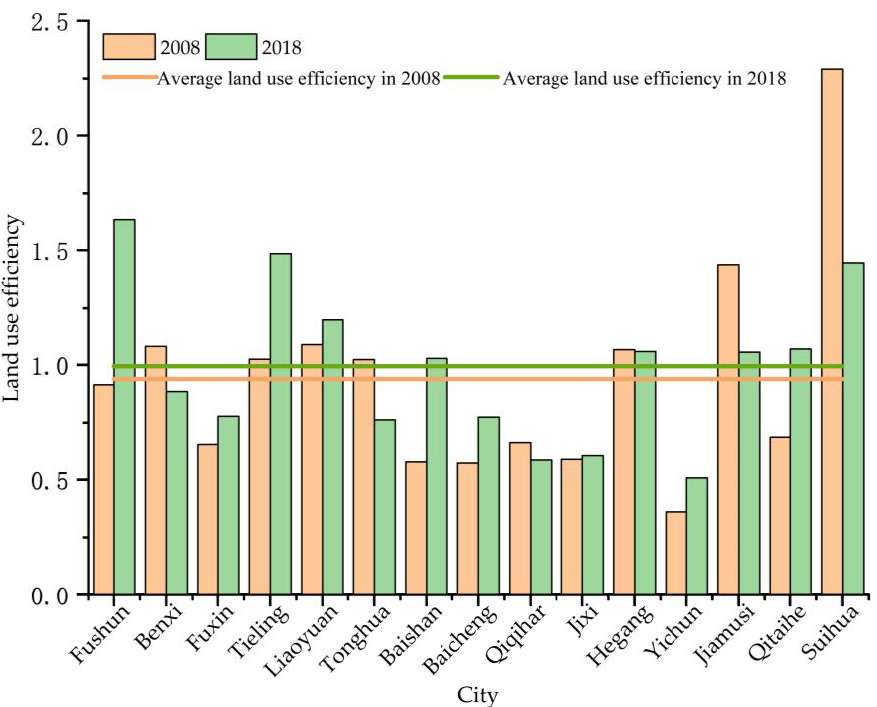
Figure 5. The land-use efficiency of shrinking cities from 2008 to 2018. The yellow line is the average land-use efficiency of the 15 shrinking cities in 2008; the green line is the average land-use efficiency of the 15 shrinking cities in 2018. (Source: Authors).